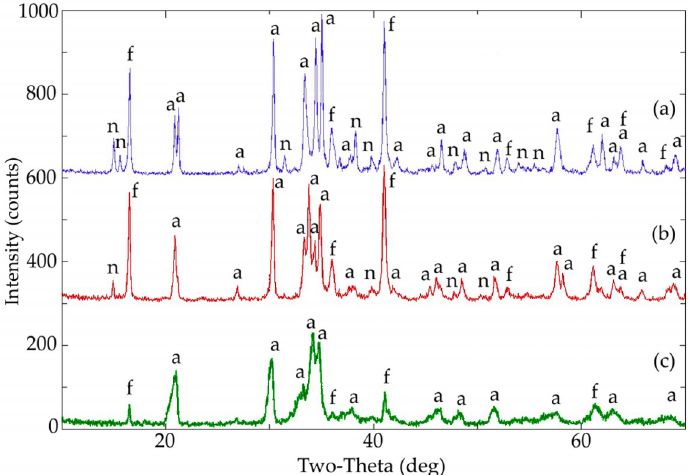
Figure 2. XRD pattern of sinters: ( a ) sinter obtained by fusion at 300 ◦ C; ( b ) sinter obtained by fusion at 500 ◦ C; ( c ) sinter obtained by fusion at 700 ◦ C. The letters stand for: a, sodium aluminate; f, sodium ferrite; n, sodium hydroxide.